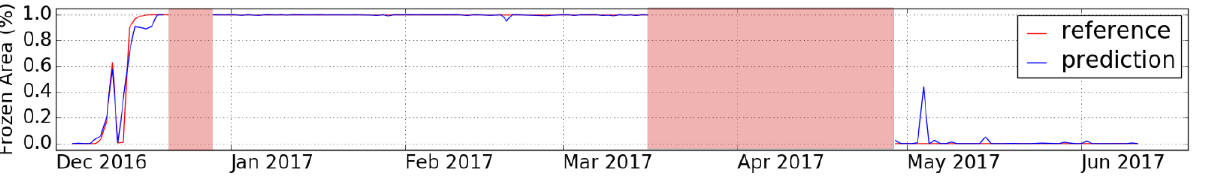
Figure 5. Predicted vs. groundtruth frozen area for Cam1. Red bars indicate periods of data gaps, where no images were